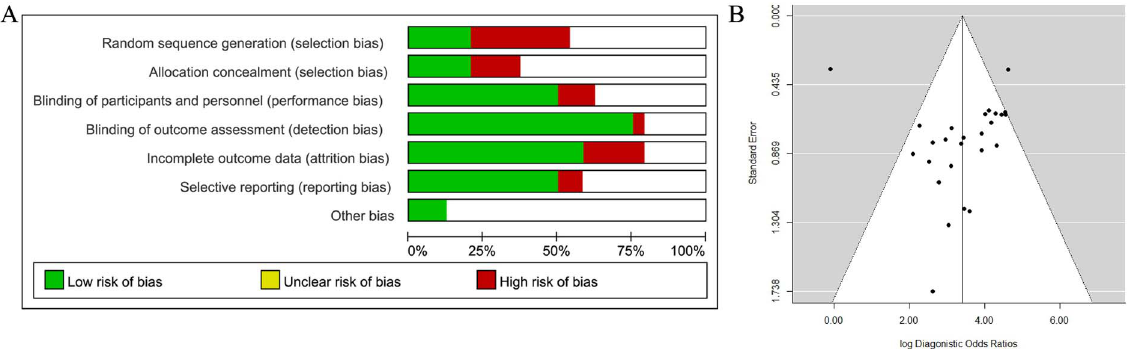
Figure 2. Methodological quality and publish bias assessment. (A) Risk of bias graph. The items of bias were independently evaluated by two authors. If the study reported all of the sensitivities and specificities of genes which were measured DNA methylation status, selective reporting was defined as low risk. (B) Funnel plot to assess bias in estimates of diagnostic odds ratio caused by small-study effects.